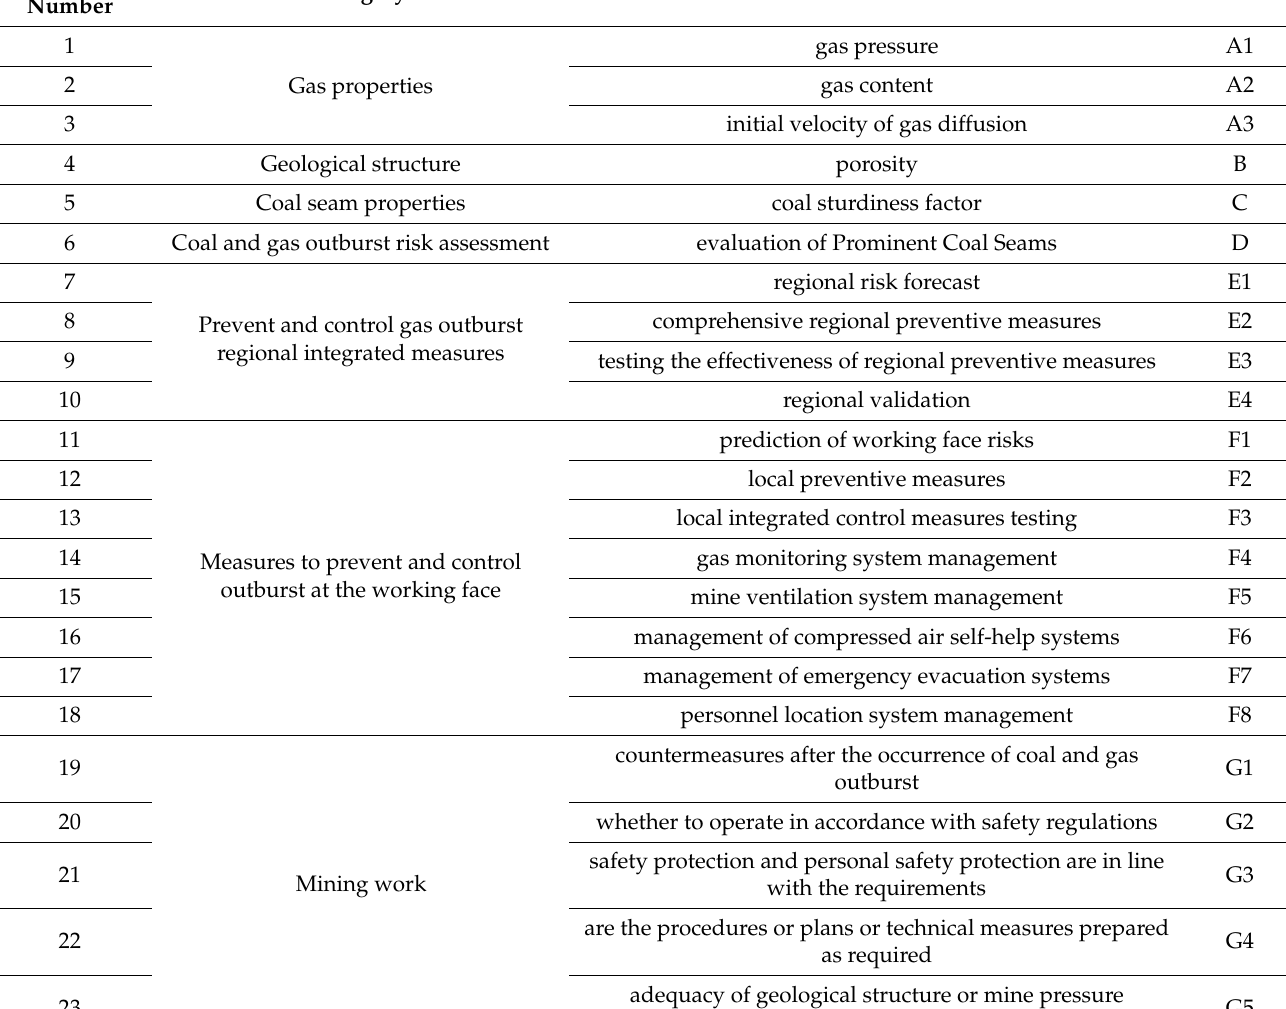
Table 4. Gas outburst risk prediction index